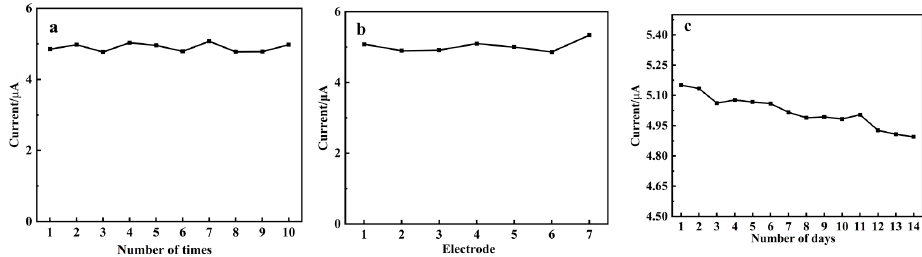
Figure 11. The reproducibility ( a ), repeatability ( b ) and stability ( c ) of CLR-PC/GCE.